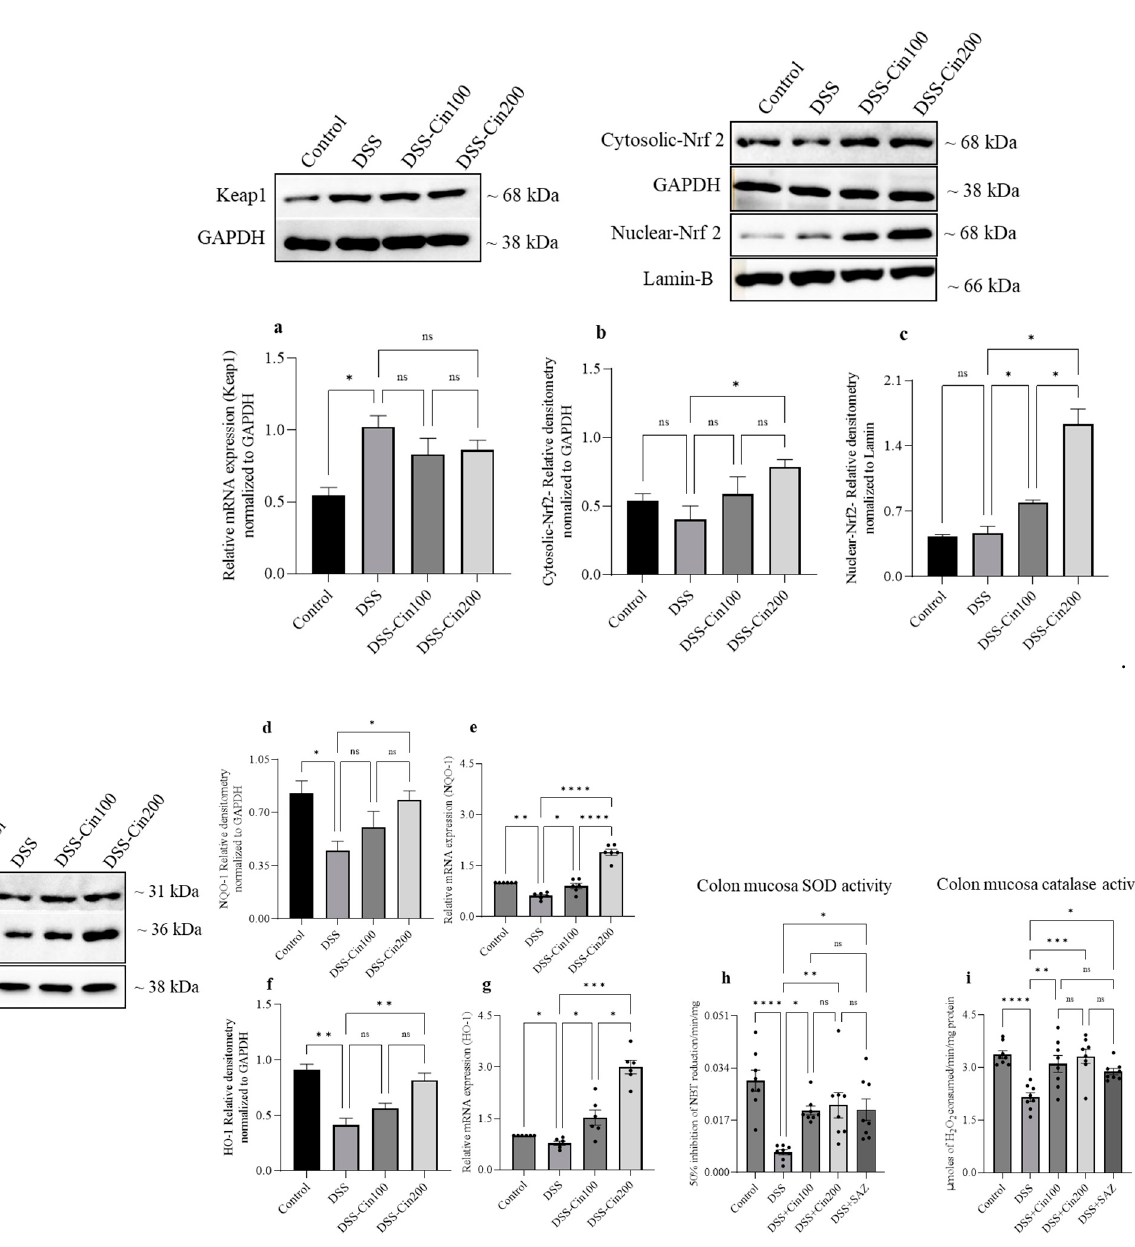
Figure 6. Effect of 1,8-cineole on Keap1, Nrf2, HO1, NQO1, superoxide dismutase (SOD), and catalase (CAT) activity. The upper panel shows ( a ) Keap1 and ( b , c ) cytosolic Nrf2 and nuclear Nrf2 protein expression. Representative protein bands were normalized to GAPDH and lamin proteins as the internal controls as shown. Densitometric analysis showed that DSS administration increased Keap1 protein expression while 1,8-cineole did not further increase Keap1 protein expression. Nuclear Nrf2 protein expression was markedly increased by 1,8-cineole treatment compared to the DSS-administered group. ( c ) DSS administration significantly decreased ( d ) NQO1, ( f ) HO1 protein, and ( e , g ) mRNA expression, while 1,8-cineole treatment prevented these decreases. DSS administration significantly decreased ( h ) colon tissue SOD and ( i ) CAT enzyme activity, while 1,8-cineole treatment restored their activities toward the control levels. Data were obtained from n = 4 for protein, n = 6 for mRNA, and n = 8 animals for SOD and CAT enzyme activity; the results are expressed as the means ± SEM. * p ≤ 0.05, ** p ≤ 0.01, *** p ≤ 0.001, **** p ≤ 0.0001, and ns indicates results that were not significant.